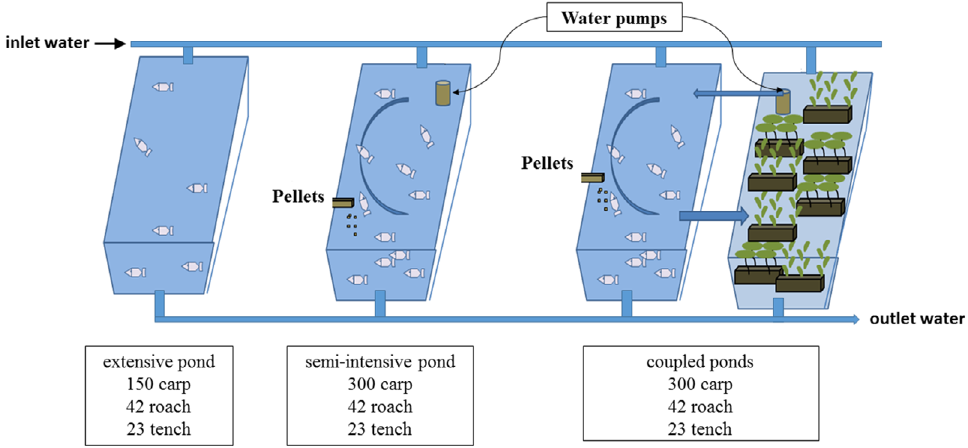
Fig. 1. Diagram of the experimental